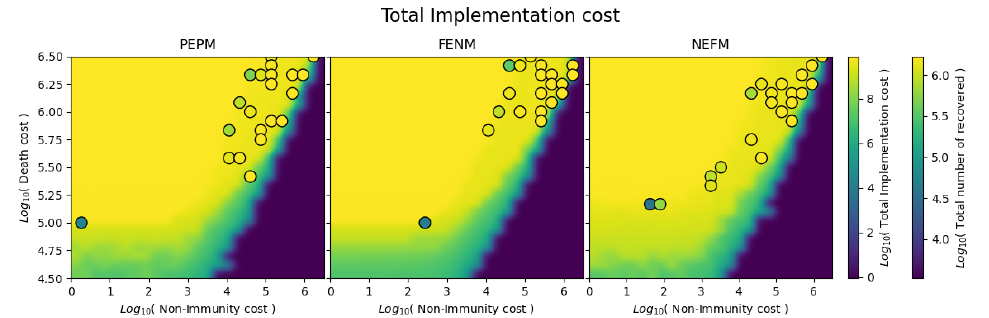
Figure 10. Heatmap showing remaining non-immune individuals as a function of death and non- immunity costs under PEPM, FENM, and NEFM algorithms, respectively. Pareto optimal solutions are indicated by hollow dots, and the dot colors correspond to the number of recovered according to the color scale at the far left. The figure shows that all Pareto optimal solutions occur in the transition region between death-nonimmune cost combinations producing low herd immunity (blue region) and those corresponding to high herd immunity (yellow region).